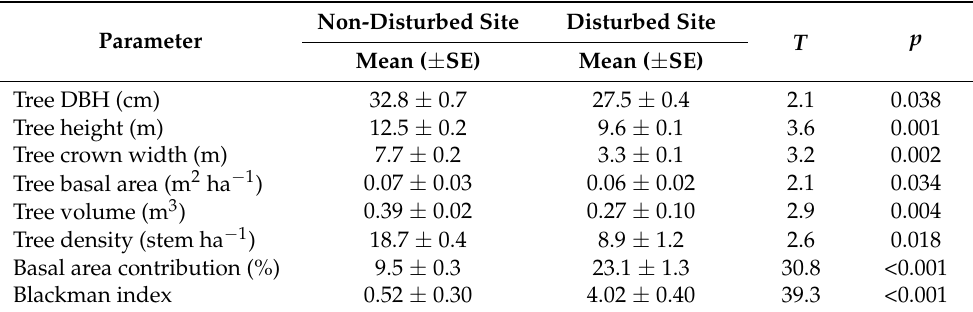
Table 1. Mean (±SE) of the dendrometric parameters and Blackman index of Balanites aegyptiaca trees in the non-disturbed and disturbed sites at the Dinder Biosphere Reserve collected over one year. DBH = diameter at breast height (measured at 1.3 m above ground level). SE = standard error, T = paired sample t test, p = probability value.